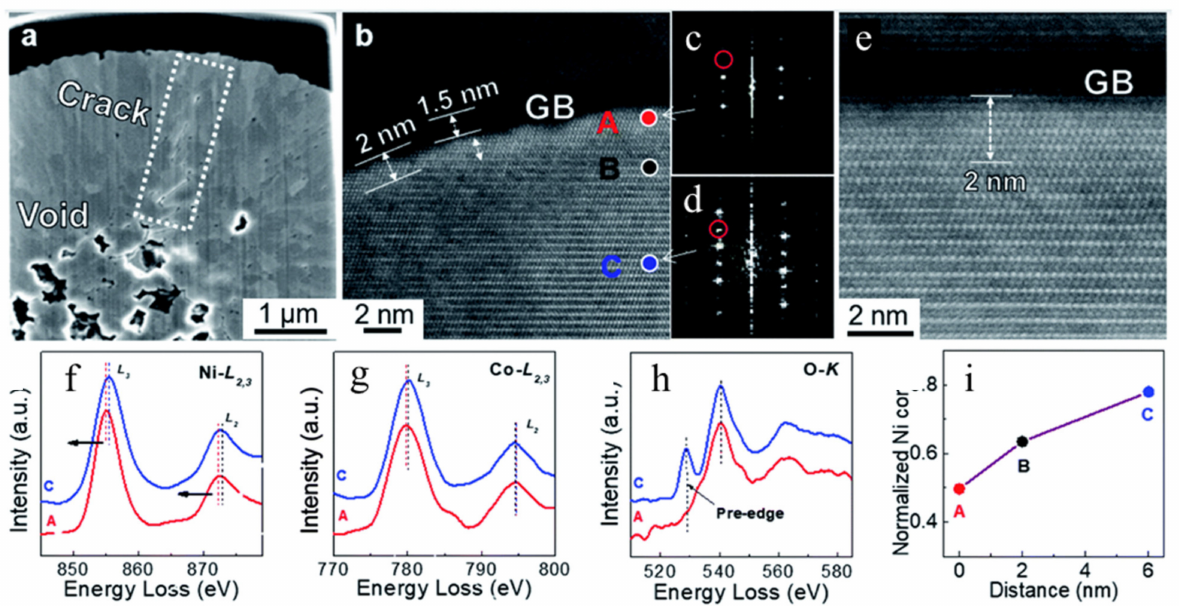
Figure 33. SEM and HAADF-STEM images of NCA after 1500 cycles. ( a ) Cross-section image of a secondary particle. ( b ) a representative GB at the microcrack line indicated in ( a ). Fast Fourier transform (FFT) pattens from ( c ) the GB and ( d ) the bulk. ( e ) a representative GB beyond the microcrack line indicated in ( a ). ( f ) the EELS spectra of Ni L-edge, ( g ) Co L-edge, and ( h ) O K-edge acquired at the points indicated in ( b ). ( i ) Normalized Ni concentration (relative to Co) from the GB to the bulk derived from EELS spectra [245]. Figure 33 reprinted with permission from the Royal Society of Chemistry Copyright